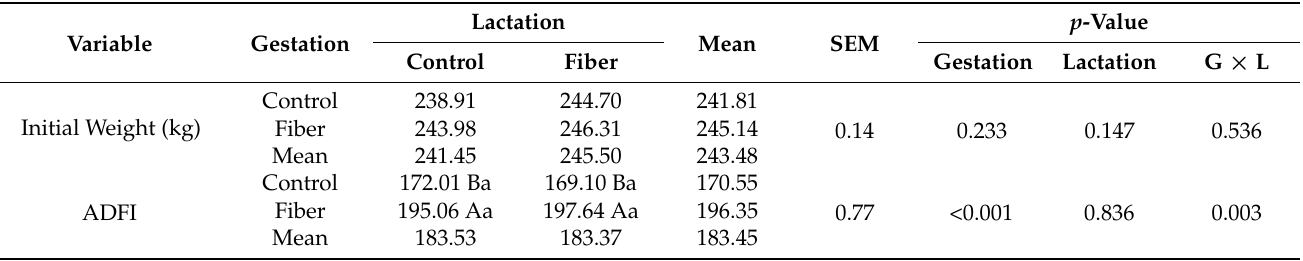
Table 4. Weight and condition score at discharge (Initial Weight and BCS) from farrowing, average lactation feed intake (ADFI), and weaning-to-estrus interval (WEI) of sows supplemented or not with dietary fiber during gestation and/or